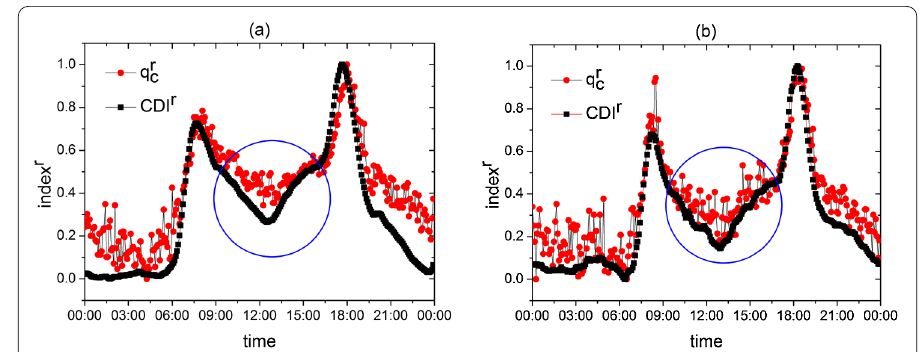
Figure 9 Fluctuation of different indices. (a) Different indices as a function of time in Beijing on Oct. 27th. (b) Different indices as a function of time in Shenzhen on Oct. 27th. Areas marked with blue circles are examples that different indices fluctuate at different frequency.